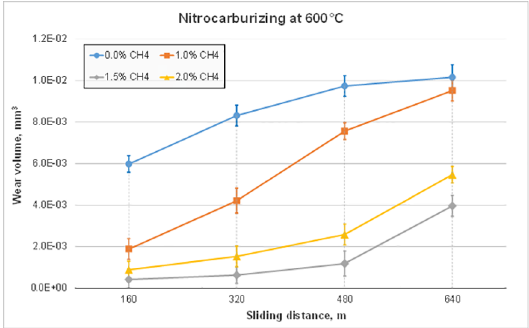
Figure 9. Wear volume for the samples nitrocarburized at 600°C as a function of methane concentration and the sliding